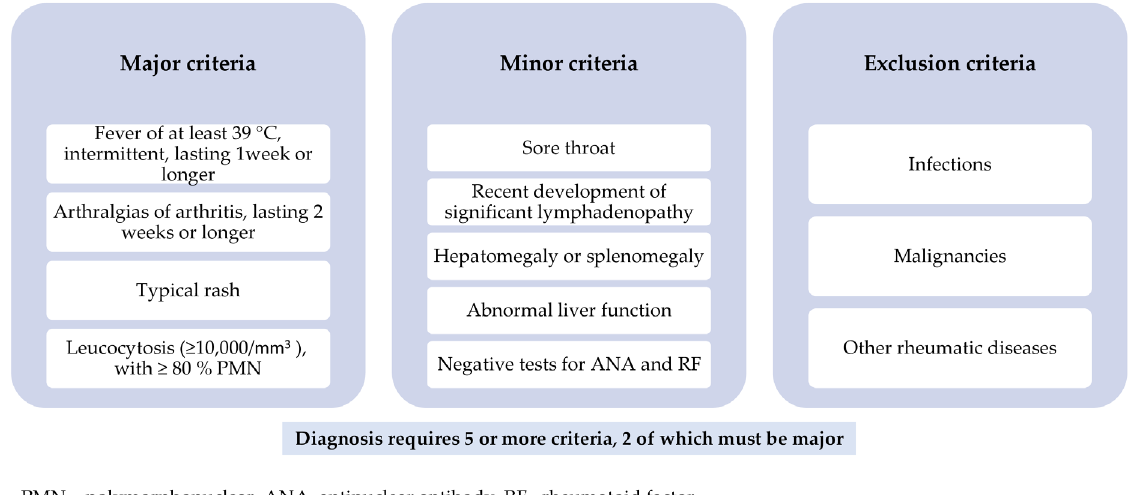
Figure 1. Yamaguchi criteria for AOSD (1992).